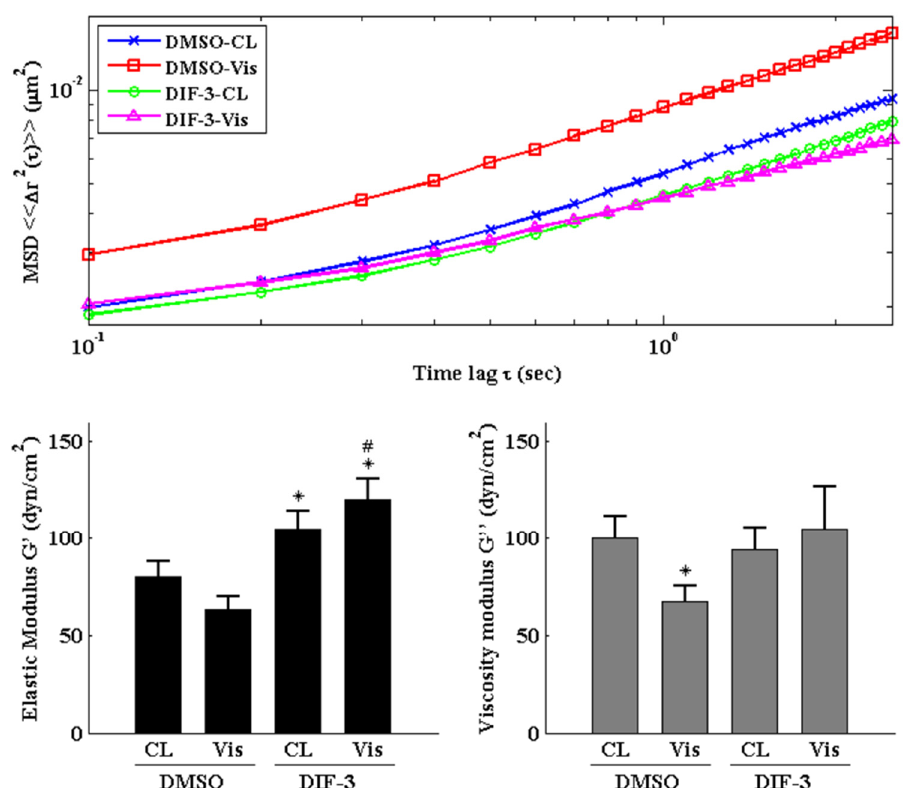
Figure 6. GSK3 β inactivation regulates visfatin-induced changes in intracellular mechanics in human primary chondrocytes. Human primary chondrocytes were pretreated with DMSO or DIF-3, a GSK3 β activator, for 1 h and then kept as controls (CL) or treated with 5 µ g/mL of visfatin (Vis) for 4 h. The intracellular mechanics, i.e., the MSD and elasticity and viscosity moduli, of human primary chondrocytes were analyzed using the PTM method. *, p < 0.05 vs. DMSO-CL-treated cells. #, p < 0.05 vs. DMSO ‐ visfatin (Vis) ‐ stimulated cells.